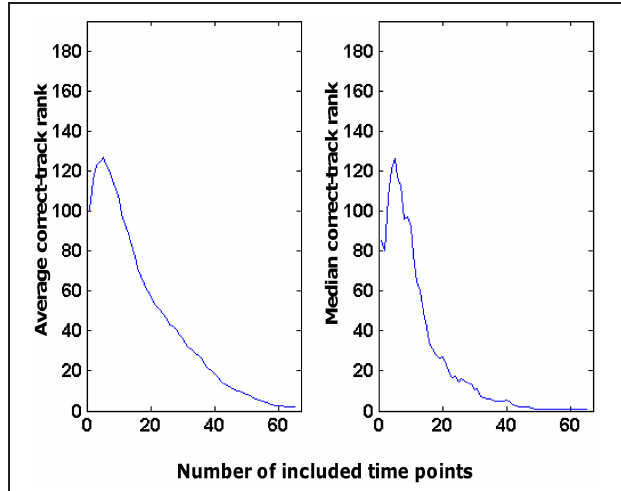
FIGURE 6 | Effect of the number of time points considered on the rank obtained by the correct track. These data are based on the use of scene RMS information in combination with the V1 ROI to choose among 390 tracks (correct-track rank expected by chance is 196).